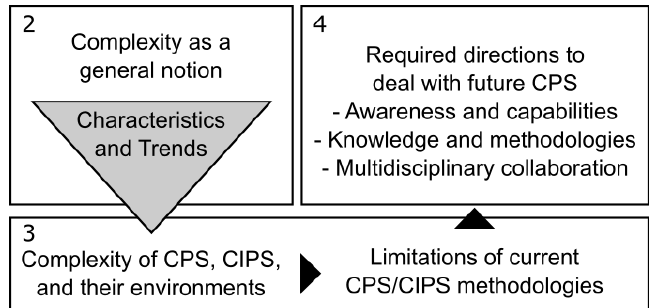
Figure 2. Graphical outline of this